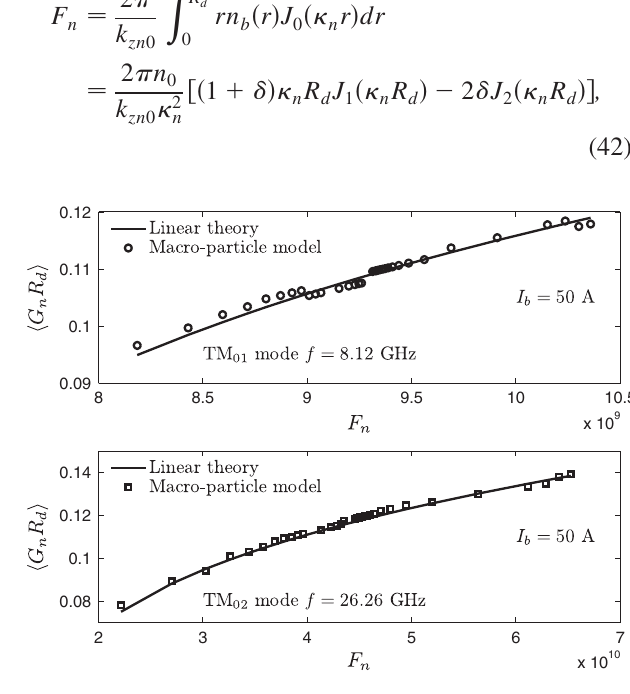
FIG. 13. Normalized growth rates for TM 01 and TM 02 modes as a function of coupling parameter, F